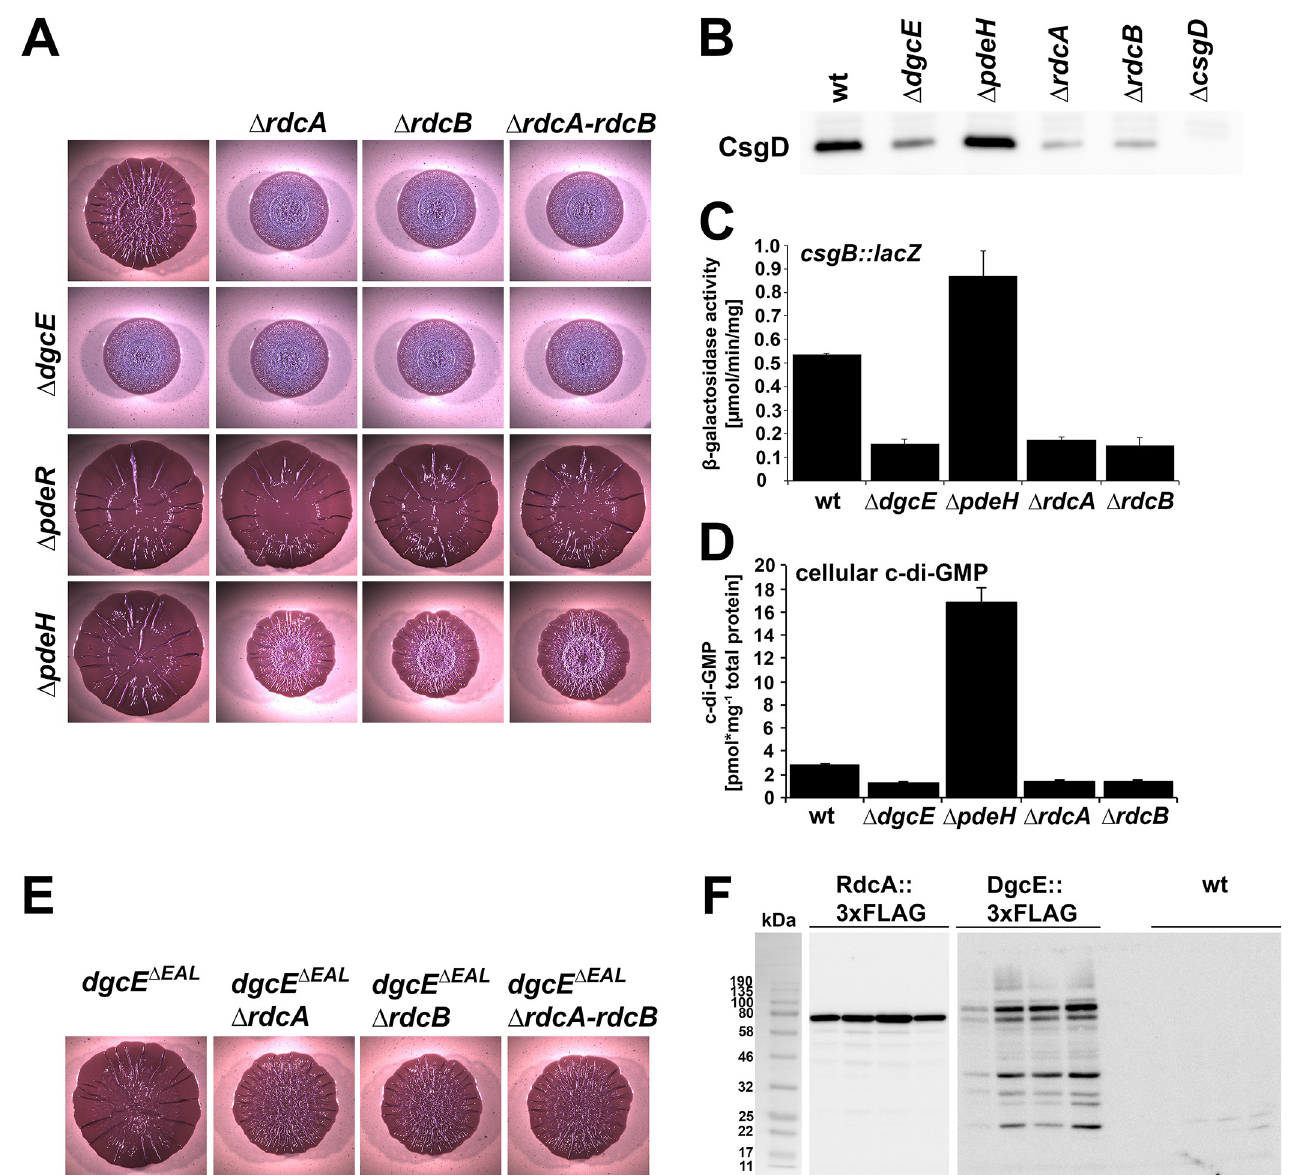
Fig 4. A role for RdcA and RdcB in DgcE-controlled biofilm-associated functions. A: Macrocolony morphology of strain AR3110 and its derivatives carrying the indicated single or double mutations. B: CsgD levels determined by immunoblot analysis in strain AR3110 carrying the indicated mutations. Samples were obtained at an OD 578 of 3.6–3.8, with 6 μ g total protein loaded per lane. C: csgB :: lacZ expression measured after growth of strain W3110 Δ lac (I-A) carrying the indicated mutations in LB at 28˚C for 24 h. D: Cellular c-di-GMP concentration determined in strain W3110, sampled at an OD 578 of 3. E: Effects of mutations in rdcA and/or rdcB on macrocolony morphology of AR3110 derivatives carrying the C-terminally truncated dgcE Δ EAL allele. F: Expression of RdcA and DgcE during the growth cycle. Both proteins carried a chromosomally encoded C-terminal 3xFLAG tag for immunoblot detection, which was performed with samples harvested at the OD 578 of 1 and 2.5, after 11 h of growth (where cells have reached an OD 578 of approximately 4.5) and after overnight growth (on). The 3xFLAG-free, but otherwise isogenic strain W3110 (wt) was used as a control.